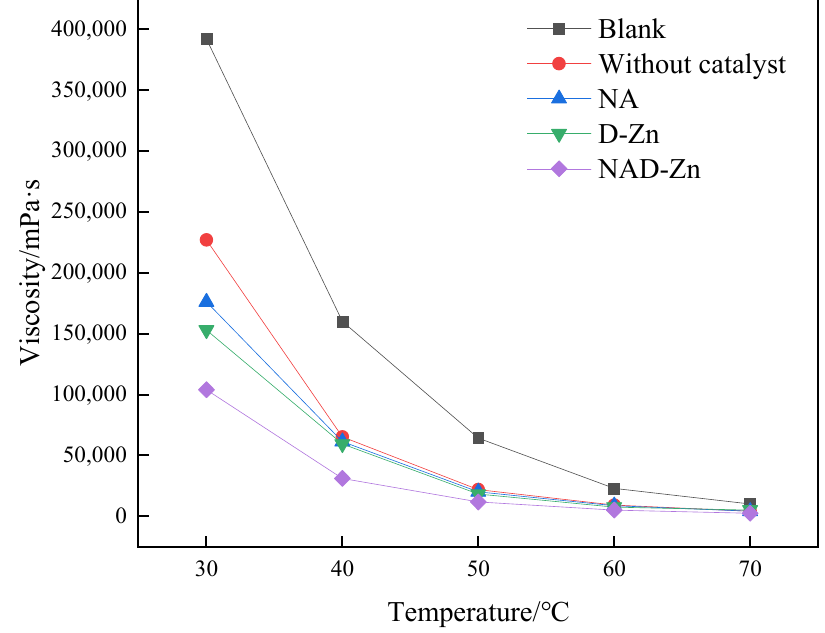
Figure 2. Effect of transition metal complexes and bentonite alone on aquathermolysis.